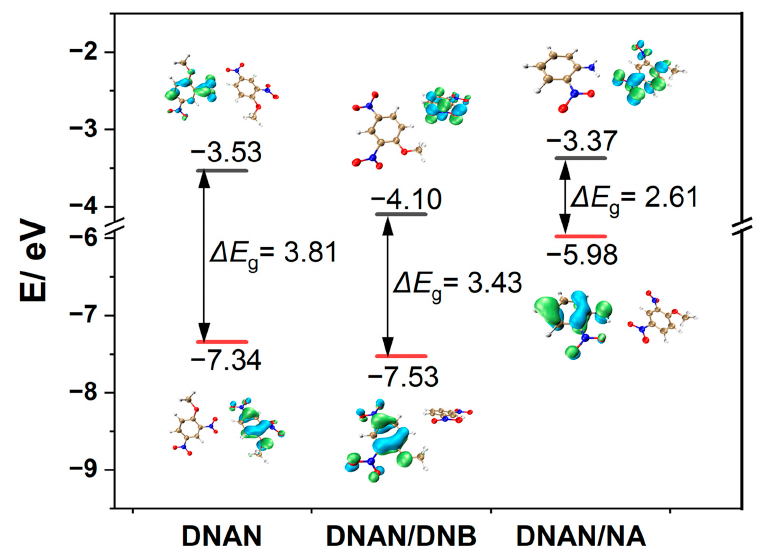
Figure 7. HOMO and LUMO and energies and ∆ E g of DNAN, DNAN/DNB, and DNAN/NA. The isovalue is 0.05 a.u. In Figure 7, green and blue represent the positive and negative isosurface, respec ‐ tively. Generally, the band gaps of the two cocrystals decrease compared with the pure DNAN crystal (3.8 eV), which suggests that cocrystallization can increase chemical ac ‐ tivity for DNAN. The HOMO energy of the DNAN/NA cocrystal is obviously elevated to − 5.98 eV from − 7.34 eV of the DNAN crystal or from − 7.53 eV of the DNAN/DNB co ‐ crystal. This can be attributed to the existence of strong electron donor group—the ami ‐ no group in NA. Hence, DNAN/NA ( Δ E g = 2.6 eV) exhibits a relatively high molecular activity, consistent with the results of EDD and DOS discussed above (Figure 6). 2.4. Melting Process Simulations Since T m significantly determines the application of melt ‐ cast explosive, we per ‐ formed MD simulations to predict T m of the DNAN ‐ based cocrystals. The crystal struc ‐ tures were optimized by the COMPASS force field prior to MD simulations. The lattice parameters were compared with the experimental results. The accuracy of the COM ‐ PASS force field was validated, since the errors are within 5% (Table S3). Figure 8a dis ‐ plays schematic detail melting procedures. The simulation temperature range is from 380 K to 530 K, including T m , and the heating velocity is set to 5 K/stage. For each stage, after 50 ps NVT ‐ MD relaxation, 150 ps NPT ‐ MD simulations were performed to simu ‐ late the melting process (Figure 8a). The specific volume density is abruptly shifted at T m , so by calculating the specific volume density, the T m values of the three crystals can be obtained (Figure 8b). Generally, for all three crystals, the specific volume densities can be separated into two distinct stages. During the solid phase, the specific volume density in the three crystals is around 0.7 cm 3 /g. With the temperature increase, the spe ‐ cific volume density also increases, as expected. Additionally, the rate of the enlarge ‐ ment of the specific volume density changes significantly at T m . In Figure 8b, the T m val ‐ ues of the three crystals can be directly obtained in the decreasing order of 495 K, 470 K, and 415 K, respectively. The result suggests that T m for the DNAN/NA and DNAN/DNB cocrystals reduces compared with the pure DNAN crystal. Similar to the results ob ‐